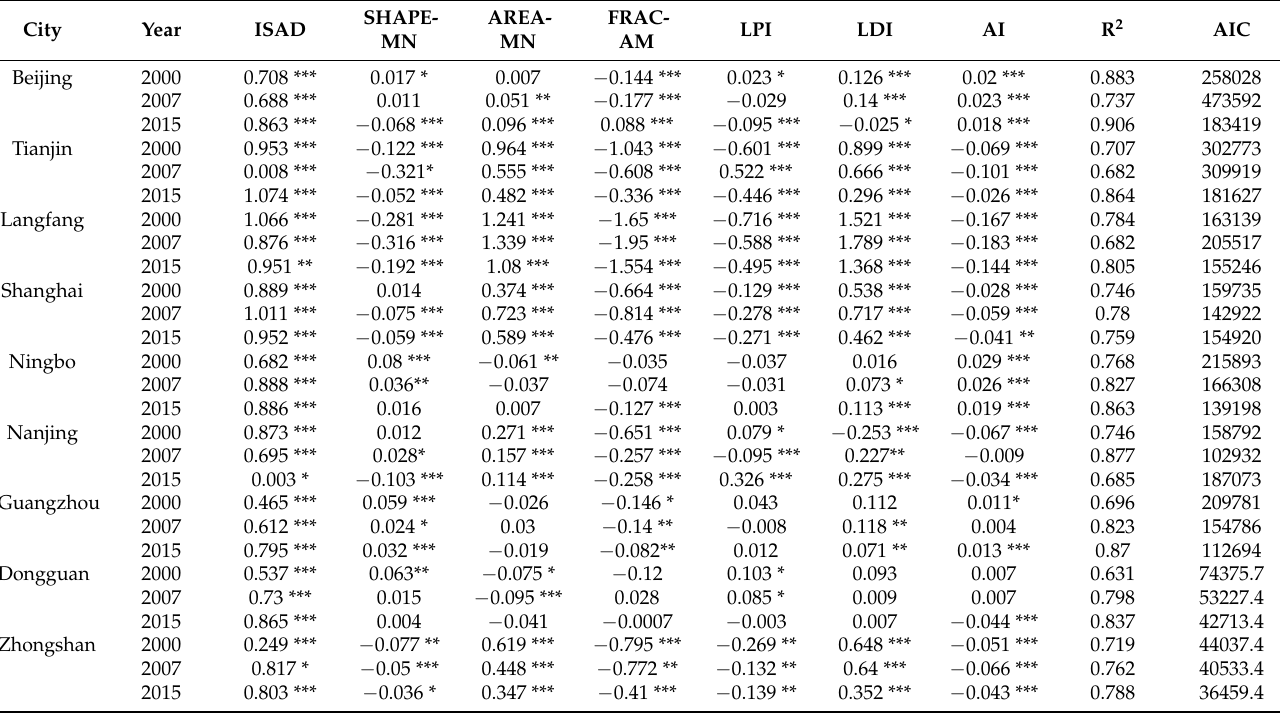
Table A5. The modeling results by the SEM of LST, UGSD and the UGS landscape configuration metrics in different cities considered in this study from 2000 to 2015. * indicates p < 0.05; ** indicates p < 0.01; *** indicates p < 0.001. City